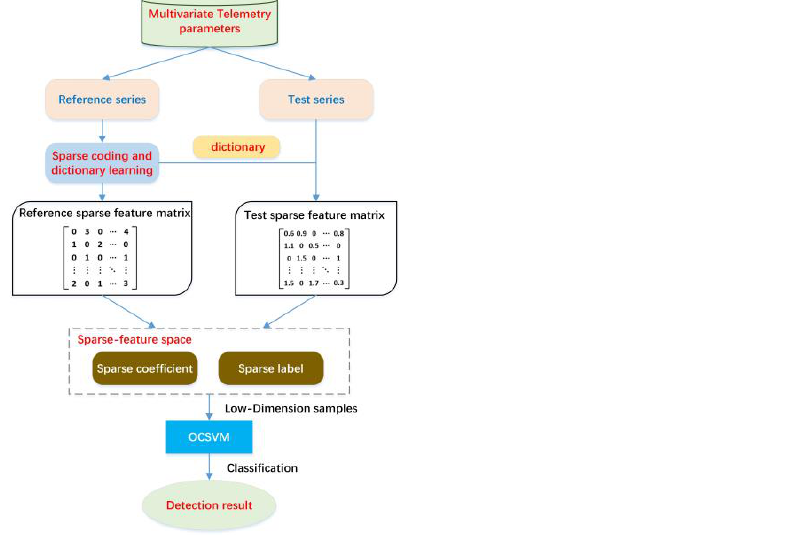
Figure 3. Semantic graph of sparse feature space. 4. Sparse Feature Extraction 4.1. Sparse Representations and Dictionary Learning Sparse representations have received widespread attention in signal and image pro- cessing applications, including signal denoising [24], detection of abnormal video motions [25] and irregular heartbeat detection [26]. The basic theories are described below. When building a sparse problem, a signal (i.e., a vector) 𝑦 ∈ 𝑅 𝑊 is equivalent to 𝑦 ≈ 𝐷𝑥 , where 𝐷 ∈ 𝑅 𝑊 × 𝑀 is a dictionary composed of 𝑀 columns called atoms and 𝑥 ∈ 𝑅 𝑀 is a sparse vector. Thus, the signal 𝑦 can be linearly represented by a few atoms in 𝐷 . The sparse problem is formulated as follows: